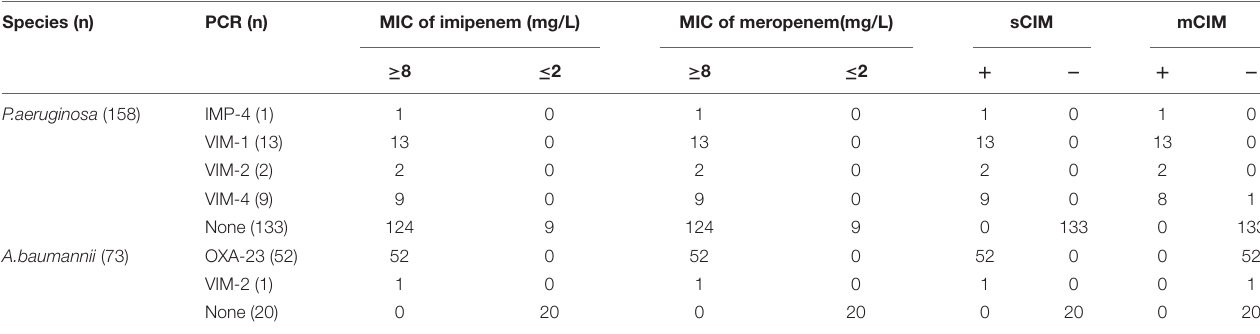
TABLE 3 | Laboratory detection of carbapenemase-producing A. baumannii and P. aeruginosa . Species